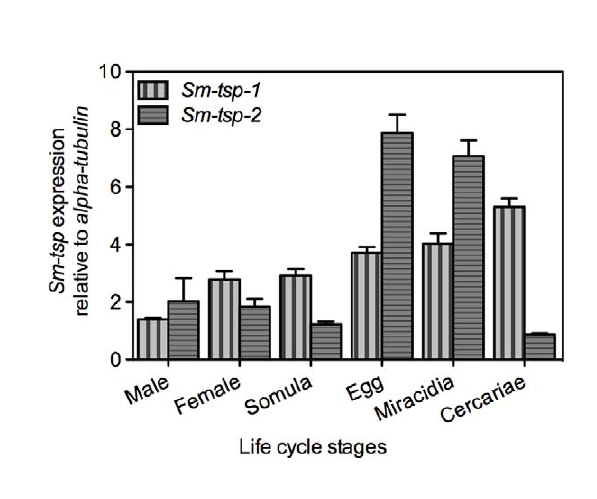
Figure 1. Expression of Sm - tsp-1 and Sm-tsp-2 at different stages of the S.mansoni life cycle. RNA levels of Sm-tsp-1 (vertical bars) and Sm-tsp-2 (horizontal bars) relative to Sm - a - tubulin were analyzed by qRT-PCR. Data are representative of mean 6 S.E. from three separate experiments.